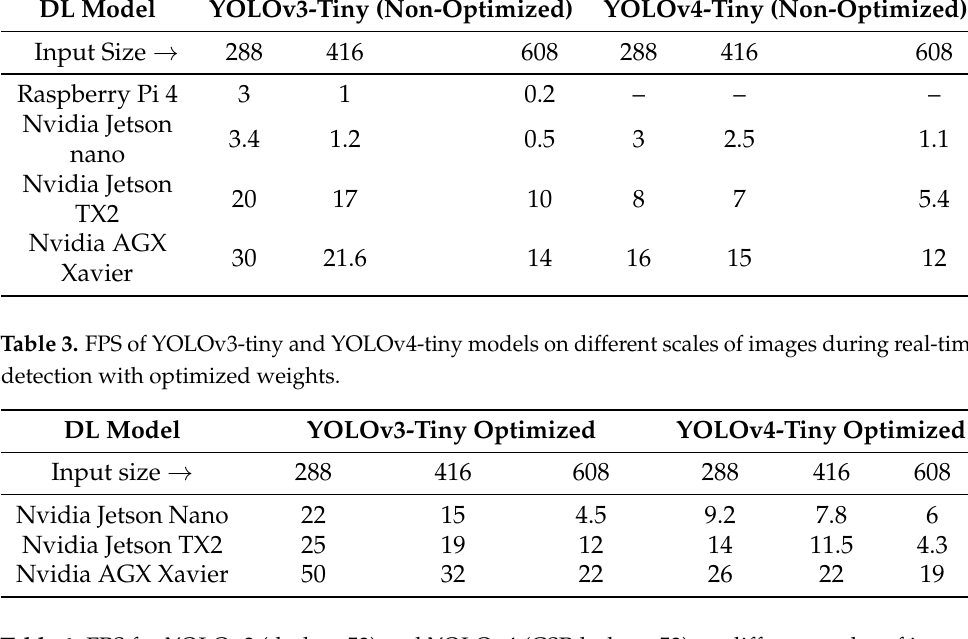
Table 4. FPS for YOLOv3 (darknet53) and YOLOv4 (CSPdarknet-53) on different scales of images during real-time detection with optimized